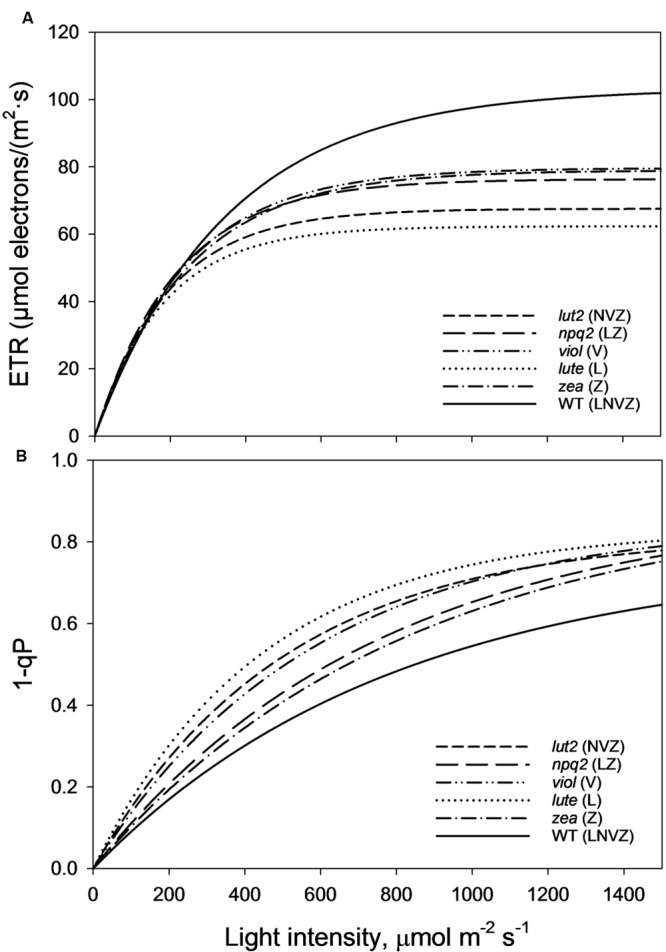
(A) Electron transport rates (ETRs) taken from the second saturating pulse after each 5 min AL illumination period (See Figure 1A). Regression analysis was performed using SigmaPlot12 (Exponential Rise to Maximum, Single 2 Parameter, f = a∗[1-exp(-b∗x)]). (B) Represents the excitation pressure recorded at each second saturating pulse after each 5 min AL illumination period (See Figure 1A). Regression analysis was performed using SigmaPlot12 (Exponential Rise to Maximum, Single 2 Parameter, f = a∗[1-exp(-b∗x)]). Thirty measurements were performed for each genotype. lut2 – no lutein, npq2 – no violaxanthin and neoxanthin, viol – violaxanthin only, lute – lutein only, zea – zeaxanthin only, WT – wild type.